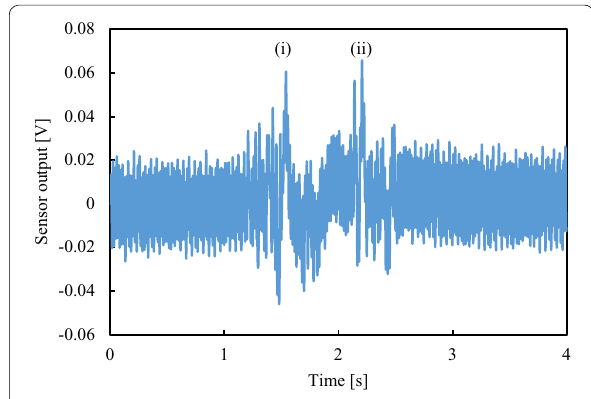
Fig. 11 Filtered sensor output in blood vessel model No. 1